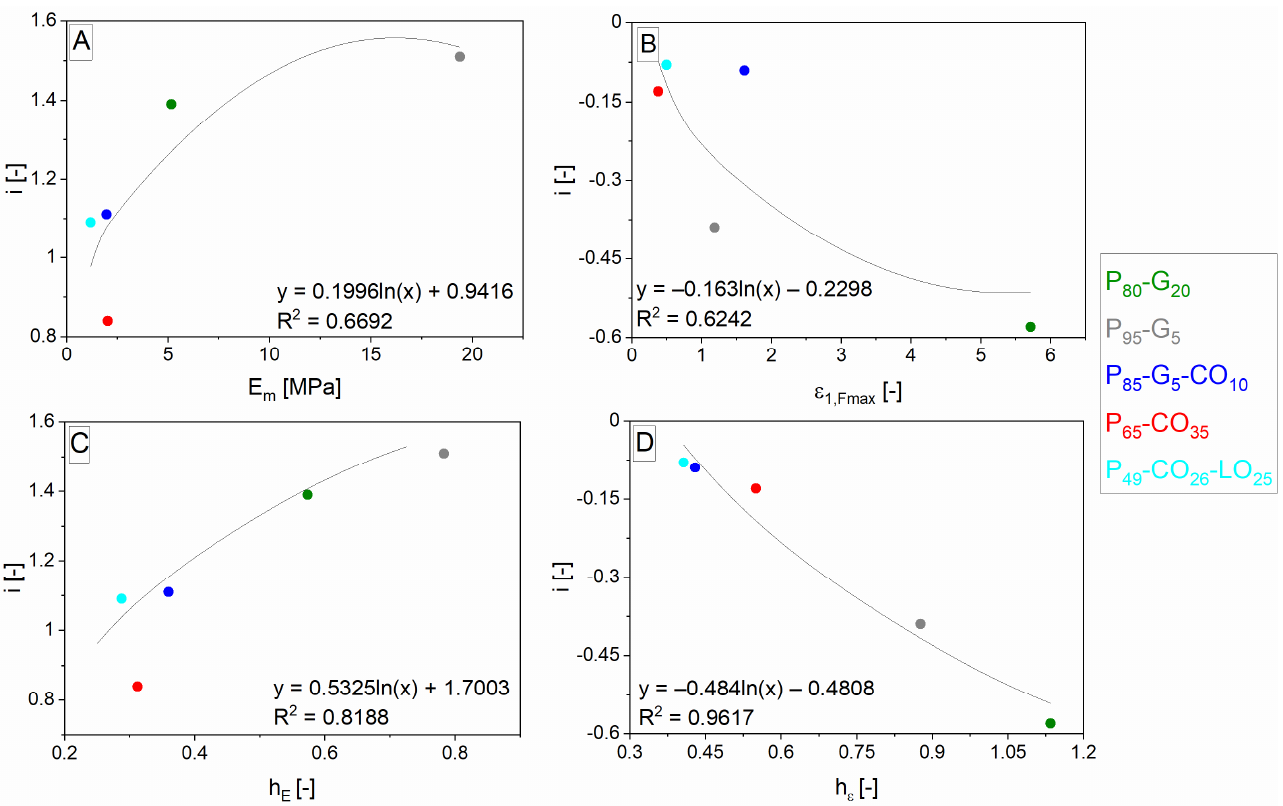
Figure 4. Dependences corresponding to the left ( A ) and right ( C ) side of relationship (26) resp. the left ( B ) and right ( D ) sides of the relationship (29). The symbol i is one from two exponents in different dependencies describing the mixing rule correction parameters η and depends on the polyurethane matrix properties or slope h of the same dependencies where they are used. The values of η , h and i vary according to described properties. Matrices designation is composed of components labeled P (polyurethane prepolymer), G (glycerol), CO (castor oil), and LO (linseed oil). Numbers (subscripts) mean vol. % of matrix components.